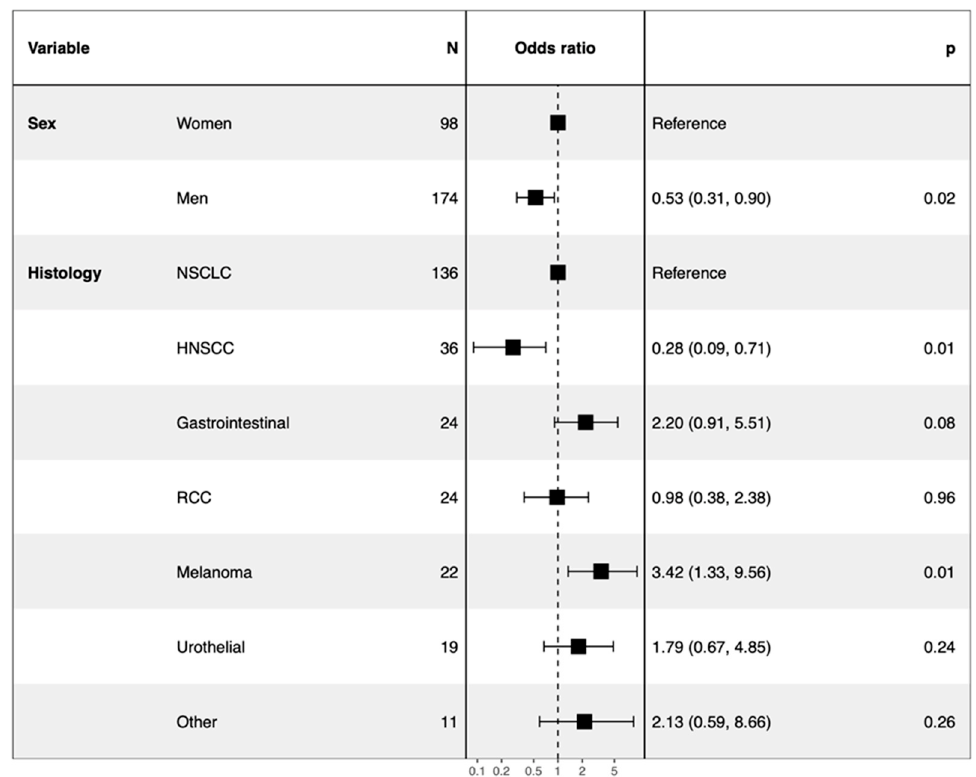
Figure 6. Forest plot of multivariate logistic regression analysis highlighting the independent factors associated with toxicity ( n = 272) .